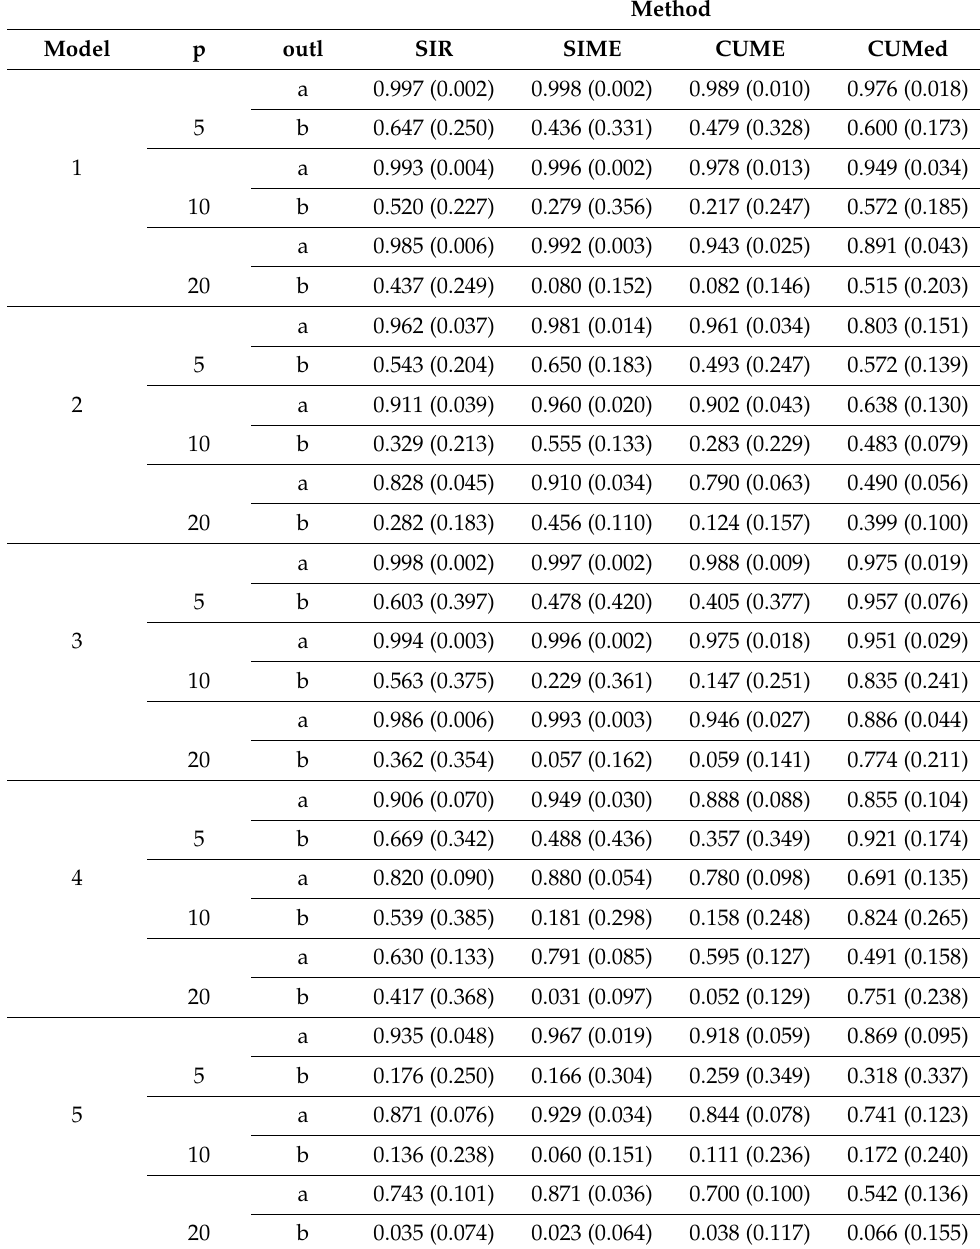
Table 1. Mean and standard errors (in parentheses) of trace correlation (4) for 100 replications for all the models for different values of p . We use n = 200 and the number of slices H = 10 in SIR and